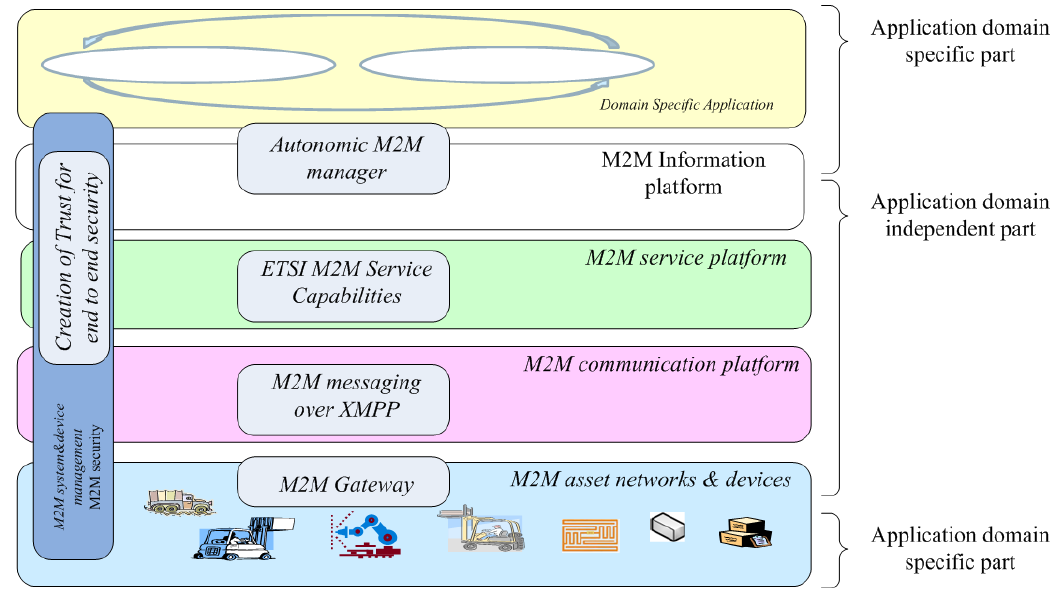
Figure 1. Machine to Machine (M2M) architecture